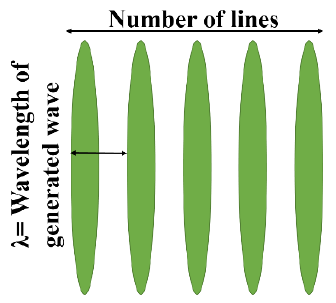
Figure 1. Schematic diagram of an LAP by using the optical system.